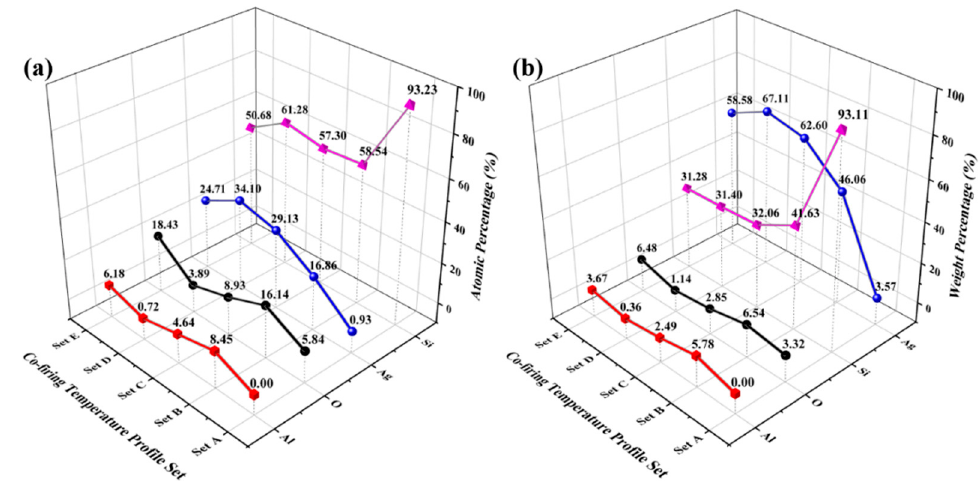
Figure 4. Energy-dispersive X-ray spectroscopy (EDS) analysis of the ( a ) atomic and ( b ) weight percentages of O, Al, Si, and Ag for the co-firing experimental sets A to E.